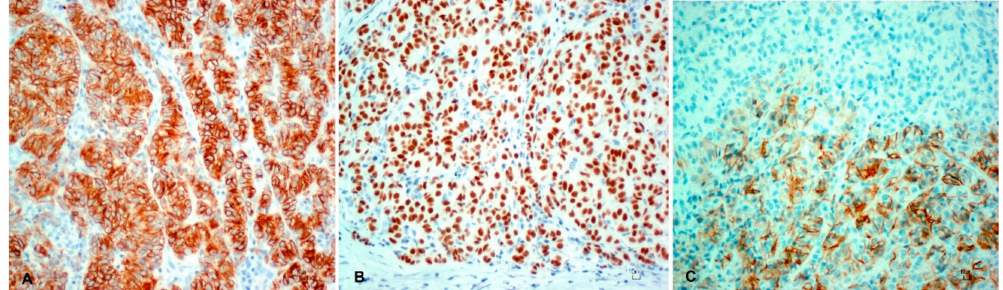
Figure 4. Immunohistochemistry. DAB and hematoxylin ( A ) Cytokeratin 5 / 6 strong and di ff use cytoplasm immunostaining of epithelial basaloid trichoblastic cells. DAB and hematoxylin. Bar 10 µ m; ( B ) P63 strong and di ff use nuclear expression of epithelial basaloid trichoblastic cells. Bar 10 µ m; ( C ) Moderate and focal cytoplasmic immunoreactivity of CD56 was multifocally detected in 8–10% of epithelial basaloid trichoblastic cells. Bar 10 µ